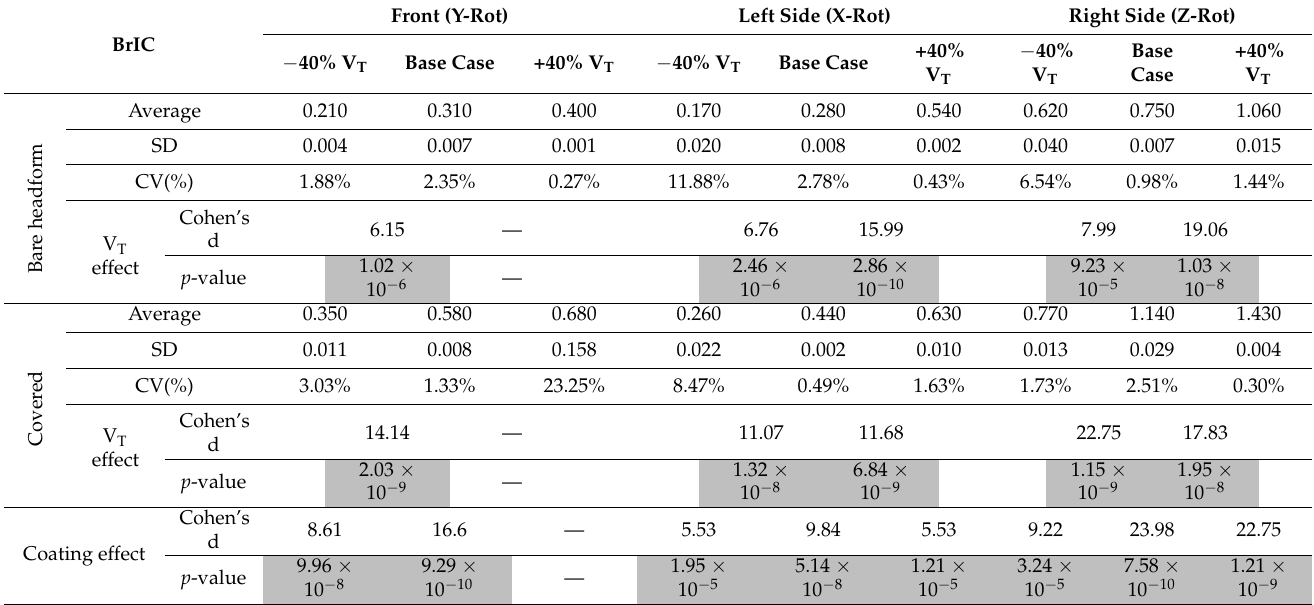
Table 7. Averages, standard deviation (SD), coefficient of variation (CV) and post-hoc results for BrIC. p -values < 0.05 portrayed as shaded cells.